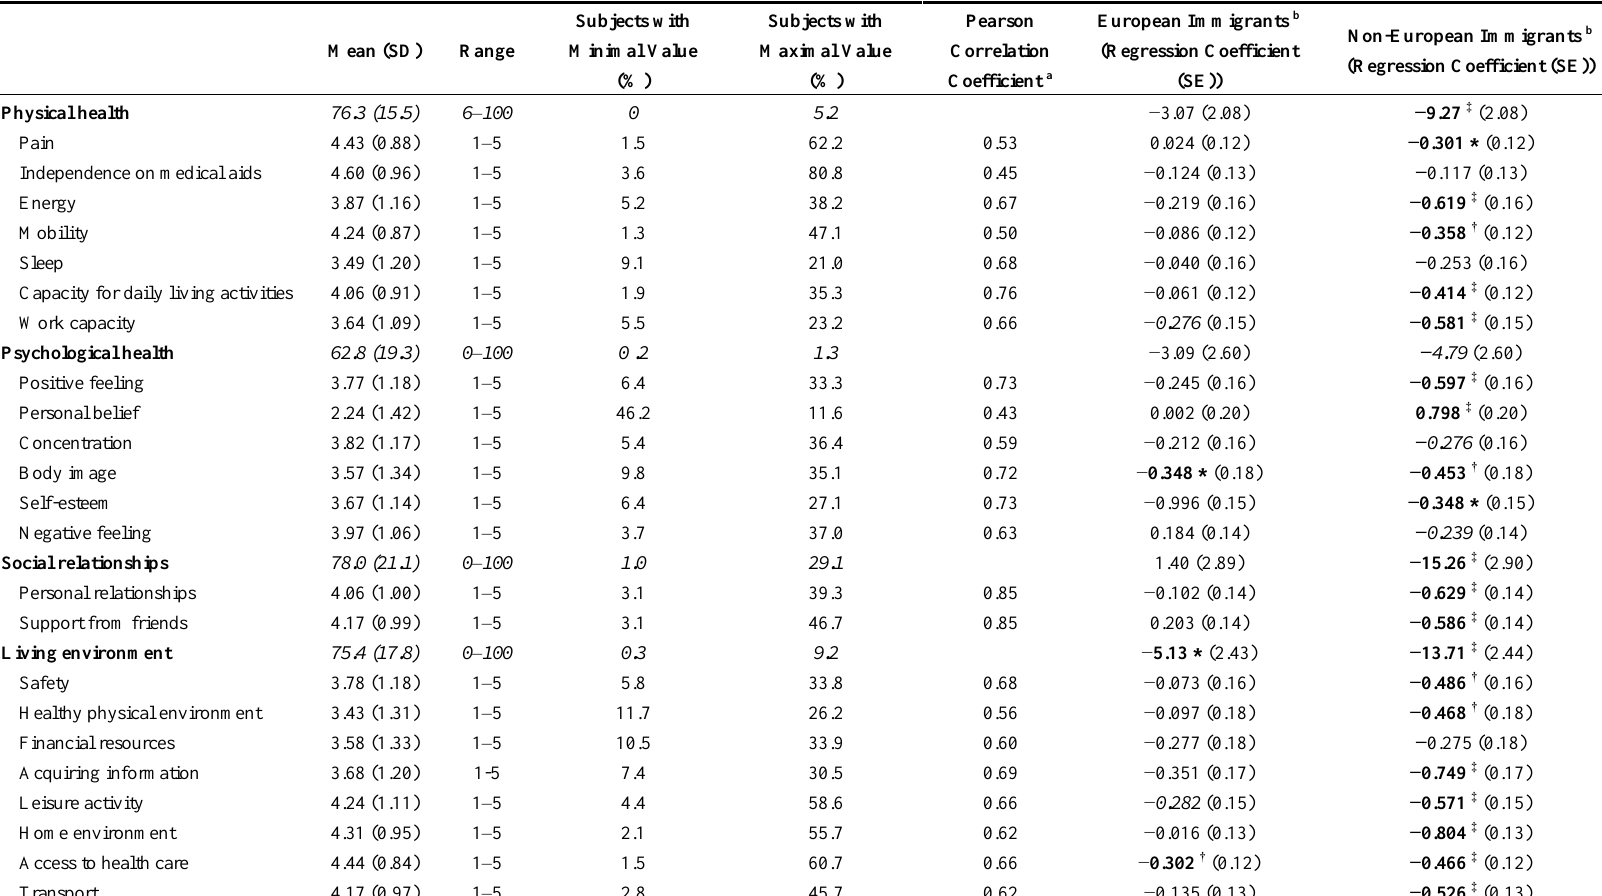
Table 1. Characteristics of WHOQOL-BREF and comparison of European immigrants, non-European immigrants with their French counterparts (N =